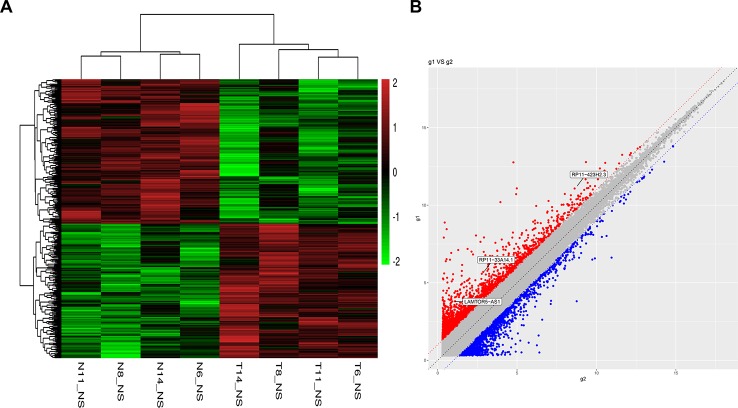
Heatmap and scatter plots of differential long non-coding RNAs (lncRNAs) in prostate tumor tissues and normal tissues. (A) Heatmap of differential lncRNAs; (B) scatter plots of differential lncRNAs.